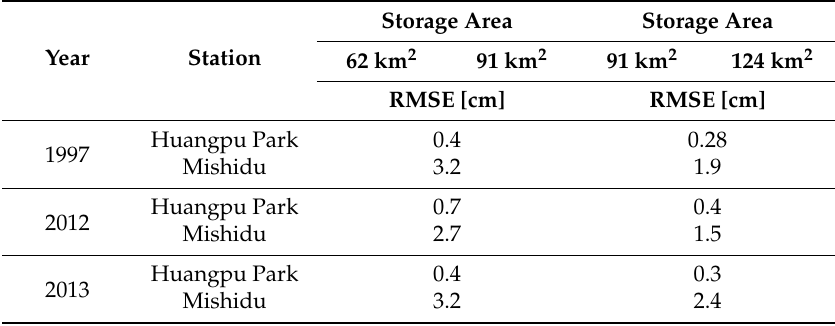
Table A1. Results of sensitivity analysis of the size of the storage area in 1D Flow